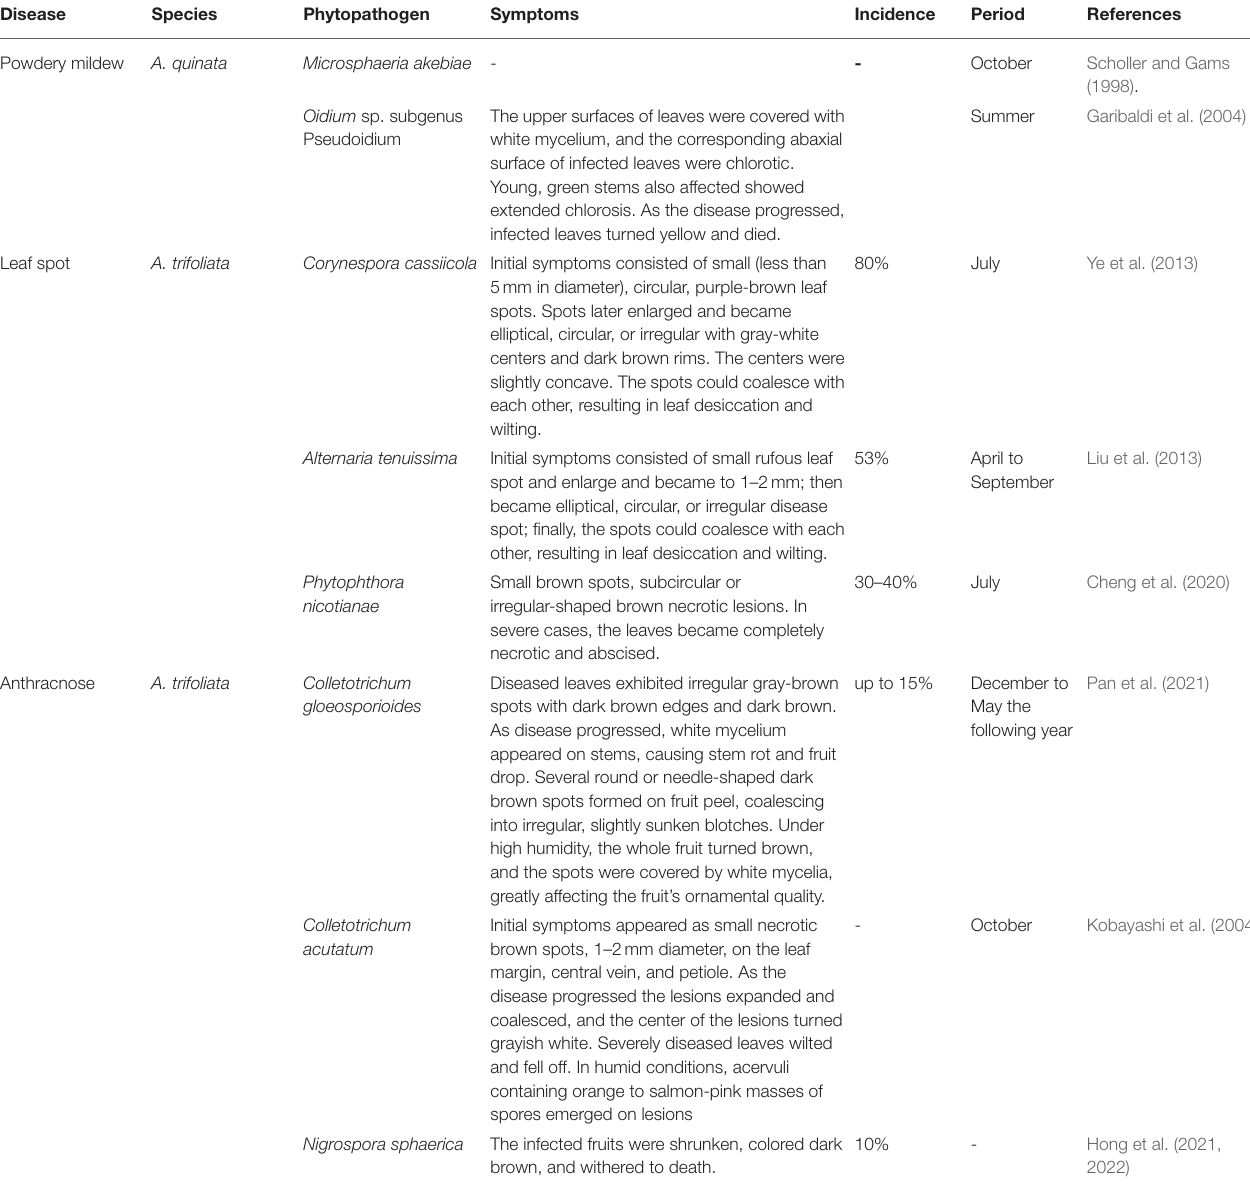
TABLE 3 | Main reported plant diseases in Akebia